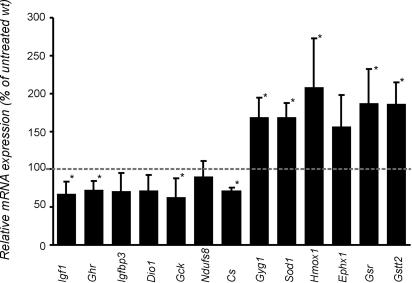
Expression Levels of Genes Associated with the GH/IGF1 Axis, Oxidative Metabolism, and Antioxidant Defense in DEHP-Treated wt MiceRelative mRNA levels of genes involved in the GH/IGF1 growth axis, oxidative metabolism, and antioxidant defense in 13-wk-old wt mice treated with a low dose of the pro-oxidant DEHP. For each gene, expression levels in the treated wt mouse livers are plotted relative to that of age-matched untreated wt littermate controls (dotted line). Error bars indicate SEM. Asterisks indicate statistically significant differences (one-tailed p ≤ 0.05, see also Text S1).